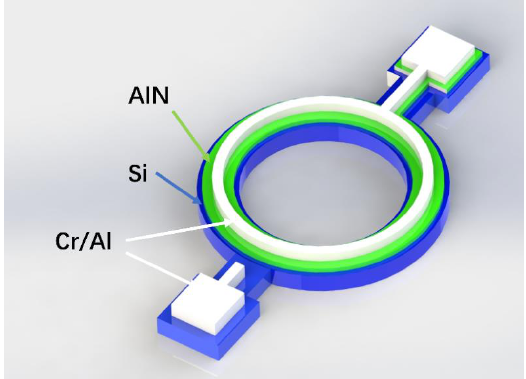
Figure 1. Schematic of the contour mode ring type resonator.